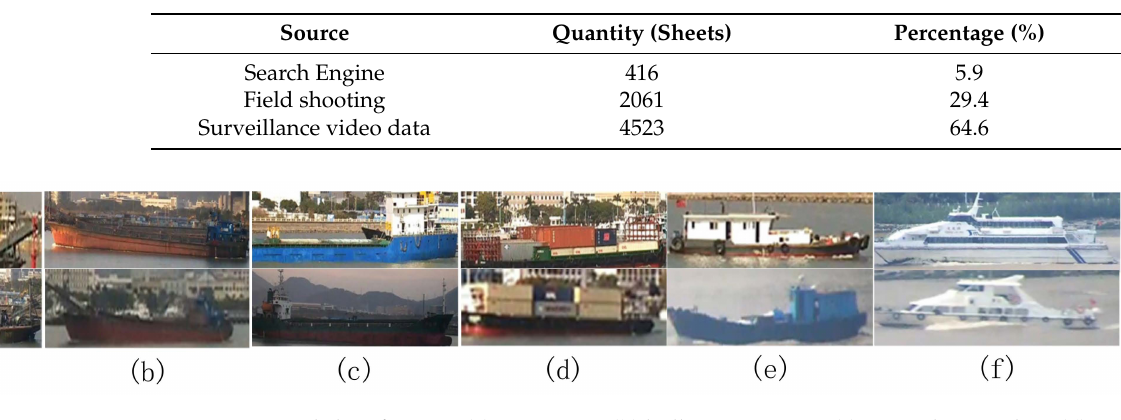
Figure 13. Vessel classification. ( a ) ore carrier. ( b ) bulk cargo carrier. ( c ) general cargo ship. ( d ) con- tainer ship. ( e ) fishing boat. ( f ) passenger ship. Table 3. Number and proportion of ship types.